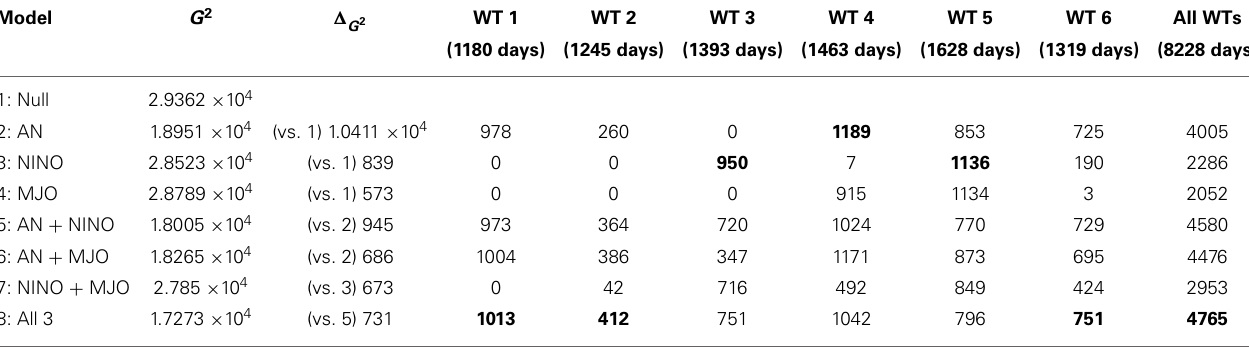
Table 2 | Fitting diagnostic and cross-validated hit rates for different multinomial logistic models (Gloneck and McCullagh, 1995), including the three distinct predictors indicated in the first column (see text); the first model (“null”) includes only the intercept and is not cross-validated. Model G